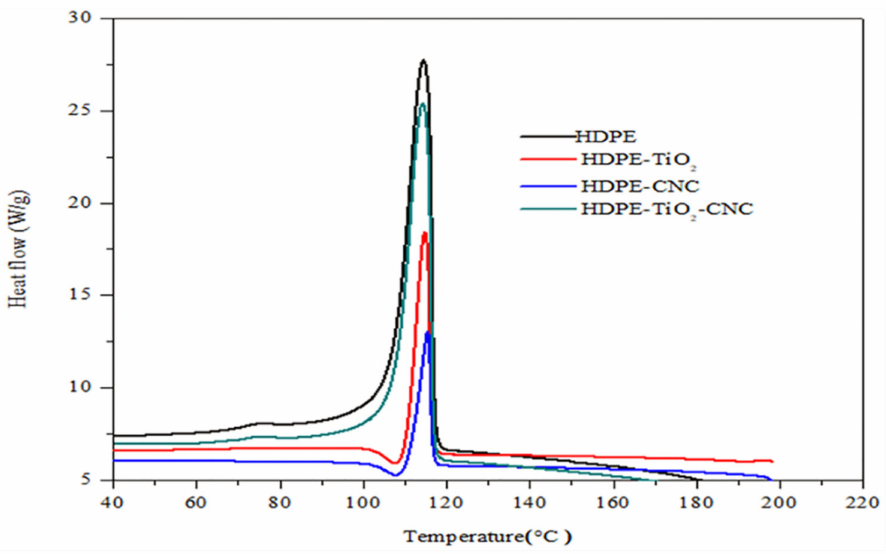
Figure 8. Effect of nanofillers (TiO 2 , CNC, and both) on the crystallization temperature of the injection-molded HDPE/n-TiO 2 /CNC nanobiocomposites. Table 4. DSC results for the HDPE/TiO 2 /CNC nanobiocomposites. Sr.